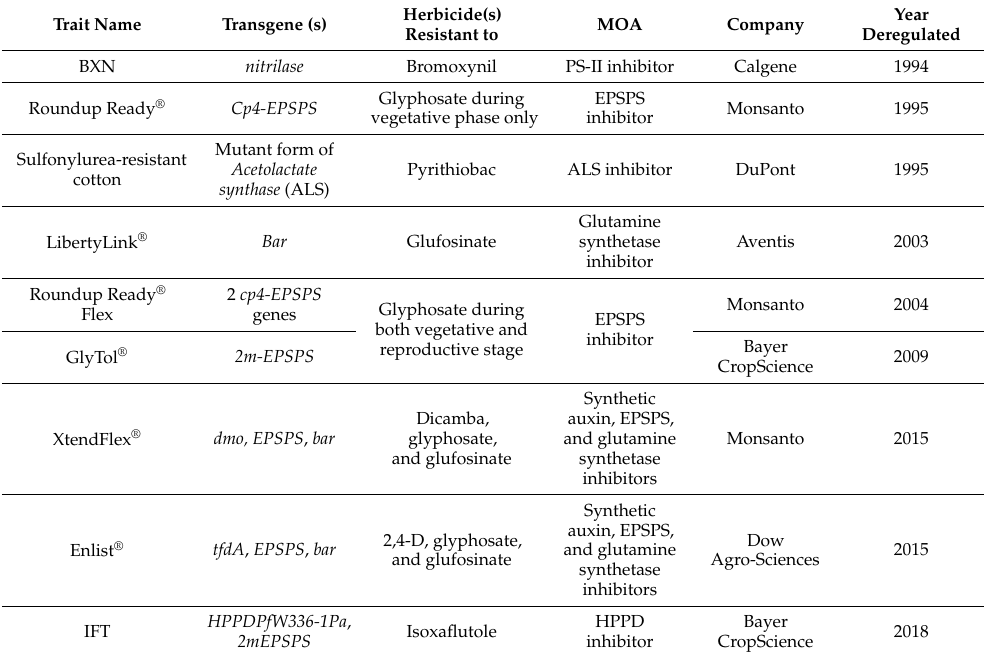
Table 1. Chronological order of deregulation of different HR traits in cotton in the